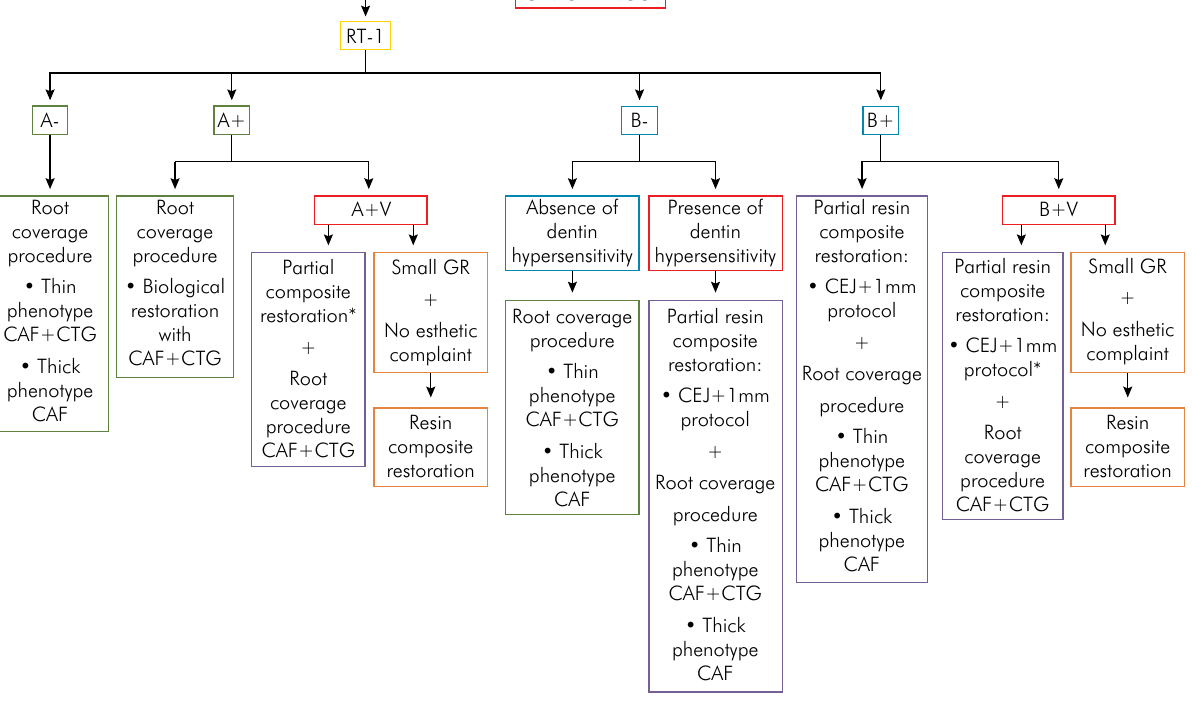
Figure 11. Strategies for the treatment of combined defects (CDs) based on the classification of gingival recession and tooth surface condition. An A- tooth surface (visible cementoenamel junction [CEJ]/no step) may be treated by a surgical procedure for root coverage selected according to the periodontal phenotype (a thin phenotype can be identified by the transparency of a periodontal probe through the gingival margin while probing the sulcus, i.e., if the probe is visible, the gingival tissue can be considered thin, and/or absence of at least 2 mm of keratinized tissue). A coronally advanced flap with connective tissue graft (CAF+CTG) should be recommended for treating recession at sites with a thin phenotype, and CAF can be performed in cases with a thick phenotype with at least 2 mm of keratinized tissue. An A+ tooth surface (visible CEJ/with step) may be treated by a surgical procedure for root coverage selected according to the periodontal phenotype. When a deep V shape is present (A+V), two options may be considered: a partial resin composite restoration with a minimum extension of the restorative material to the apical portion of the root surface defect followed by CAF+ CTG or, in the case of a small recession, considered insignificant by the patient, only restoration of the non-carious cervical lesion (NCCL) may be performed (no periodontal surgery). A B- tooth surface (no visible CEJ/no step) may be approached by one of these two options: only a root coverage procedure or a combined restorative plus surgical approach. If the patient presents with severe dentin hypersensitivity, it may persist even after the root coverage (the exposed coronal dentin will not be covered by soft tissue). In these cases, a restorative procedure to reconstruct the destroyed enamel and part of the root (CEJ+1 mm protocol, i.e., the apical margin of the restoration placed 1 mm apical to the estimated CEJ level) can be done followed by the root coverage procedure. A B+ tooth surface (no visible CEJ/with step) is characterized by a deep NCCL affecting both root and crown. Thus, the CEJ is lost, and steps or significant discrepancies can be observed not only at the coronal border but also at the apical border of CDs. When a non-V-shaped NCCL is present, its most coronal zone may be restored with resin composite (CEJ+1 mm protocol) before the surgical procedure. A CAF+CTG for a thin phenotype and CAF for a thick phenotype can be performed. When an extremely deep V shape is present (B+V), two options may be considered: a partial resin composite restoration (CEJ+1 mm protocol) followed by CAF+ CTG or, in the case of a small recession, considered insignificant by the patients, only restoration of the NCCL may be performed (no periodontal